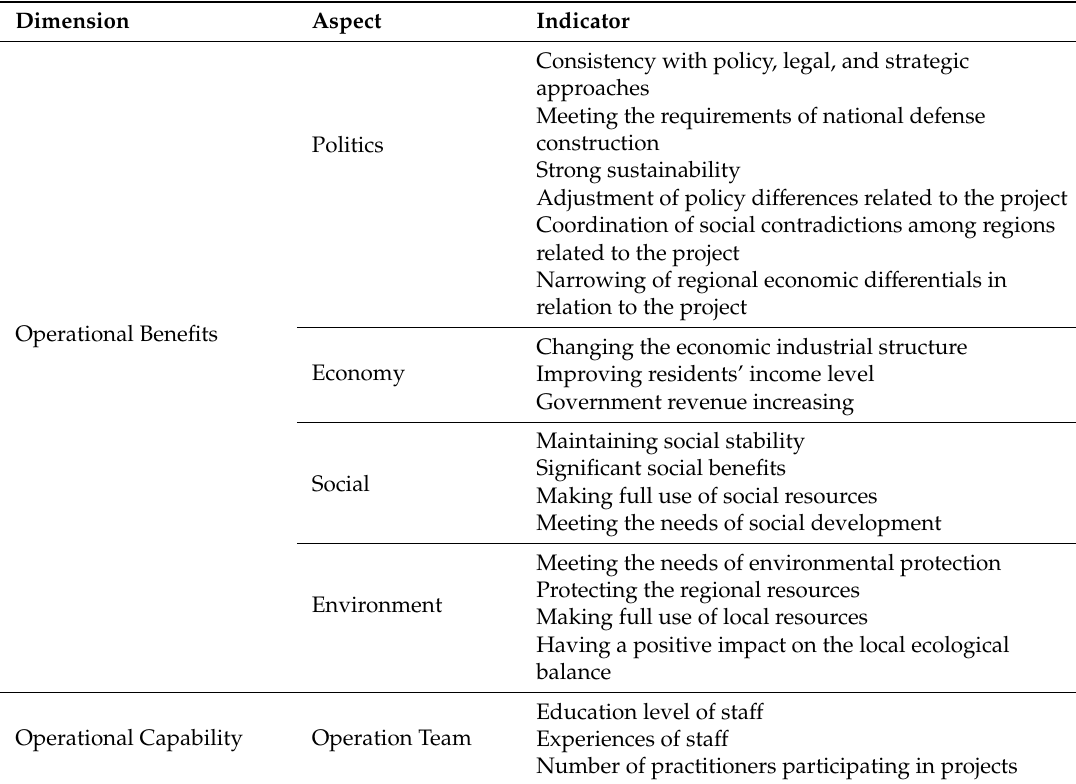
Table 3. Indicators from expert